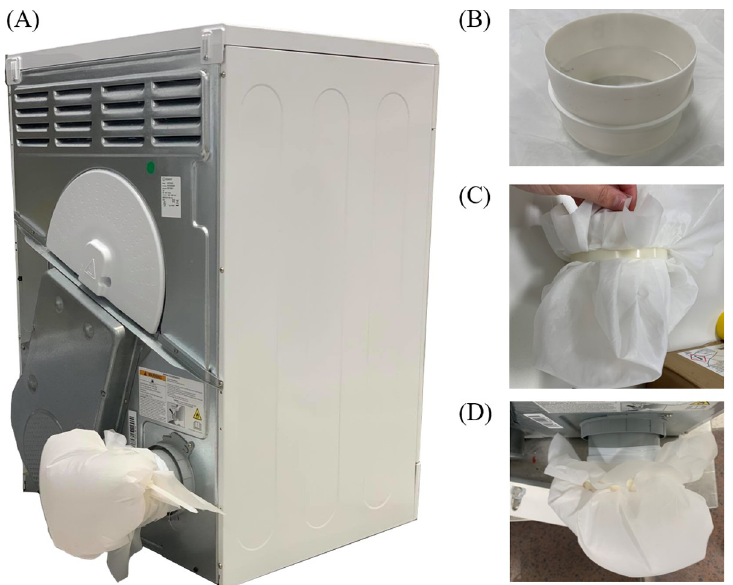
Fig 1. Tumble dryer images. Rear of tumble dryer (A ) with 20 μ m CellMicroSieve 1 installed to collect microfibers from the exhaust. The CellMicroSieve 1 is secured to a 100 mm plastic pipe connector ( B ) using a cable tie as shown in ( C ). The pipe connecter was then secured to the dryer exhaust pipe using electrical tape as shown in ( D